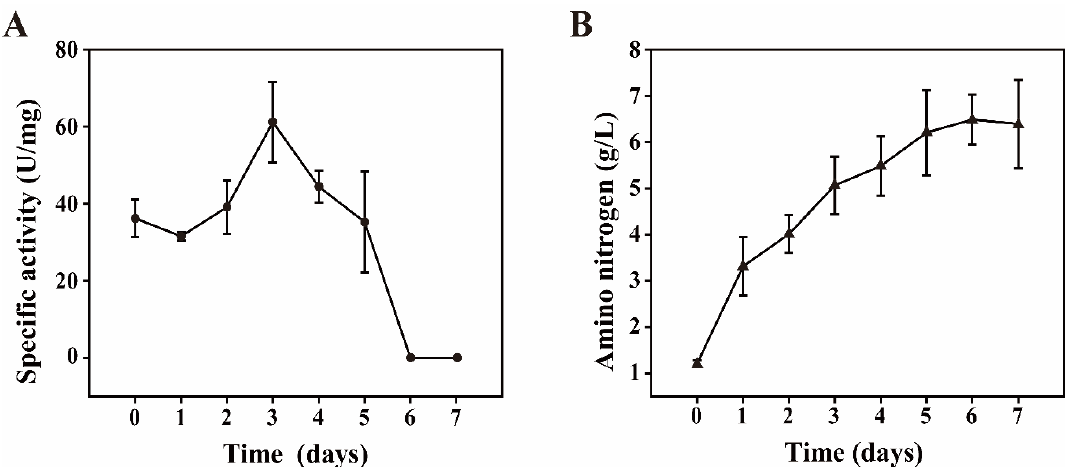
Figure 3. The salt-tolerance of neutral protease excreted from Aspergillus oryzae. ( A ) Dynamic curve of specific protease activity in neutral and hypertonic conditions. ( B ) Dynamic curve of amino nitrogen concentration in neutral and hypertonic conditions.